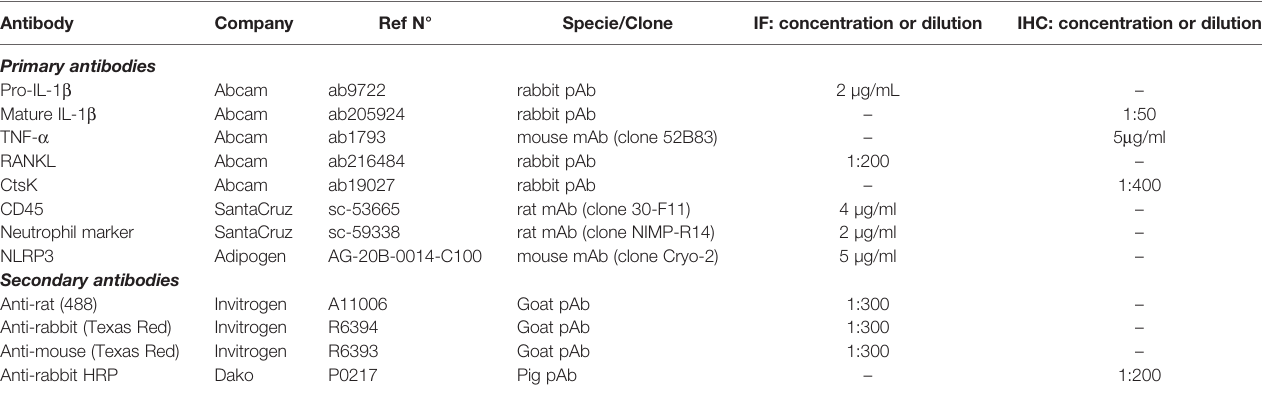
TABLE 1 | List of primary and secondary antibodies